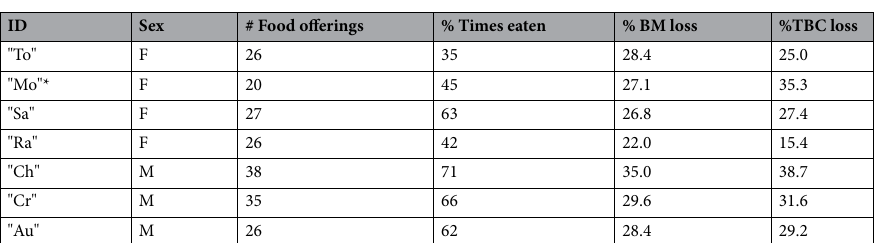
Table 1. Number of times food was offered (# Food offerings) compared to how often it was eaten (% Times eaten), body mass loss (% BM loss) and tail base circumference loss (% TBC loss) during the study period. *"Mo" individual was removed from study early, data not included in statistical analysis.